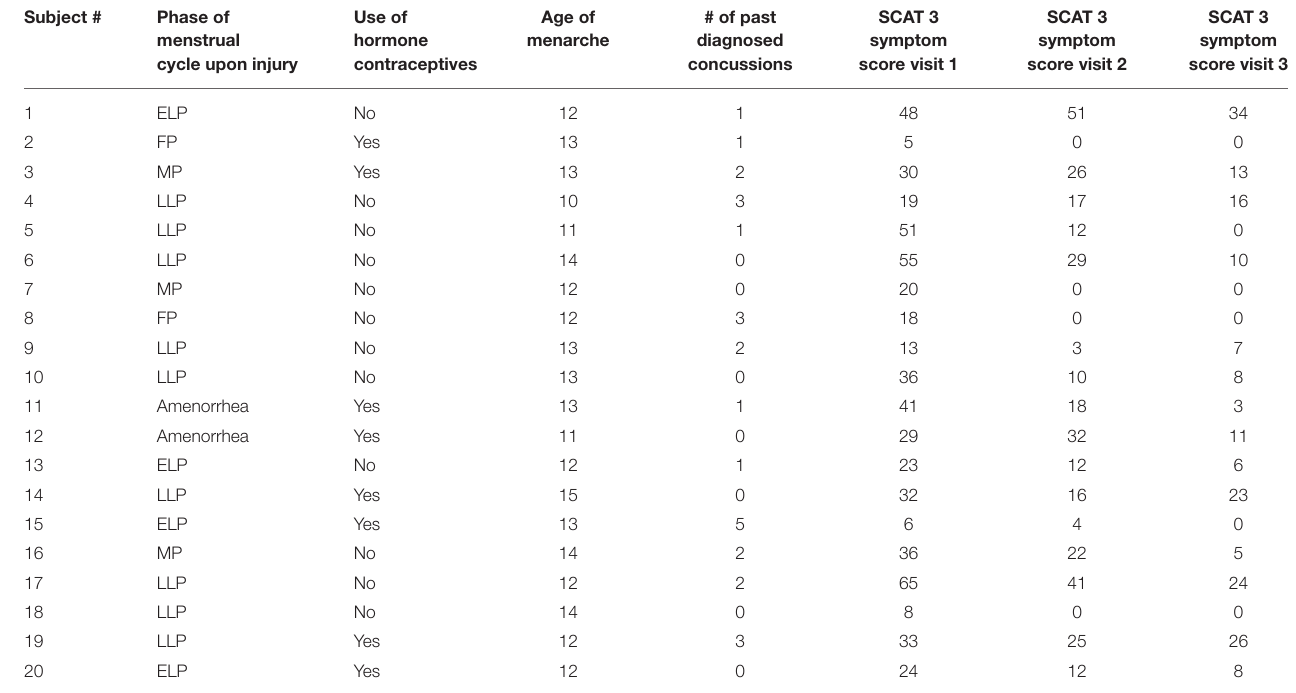
TABLE 1 | Characteristics of study